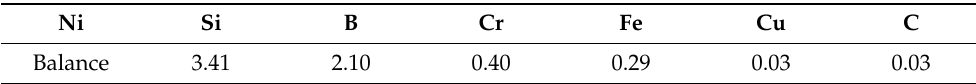
Table 1. Nominal chemical composition of the NiSi3B2 alloy (wt.%). Ni Si B Cr Fe Cu C Balance 3.41 2.10 0.40 0.29 0.03